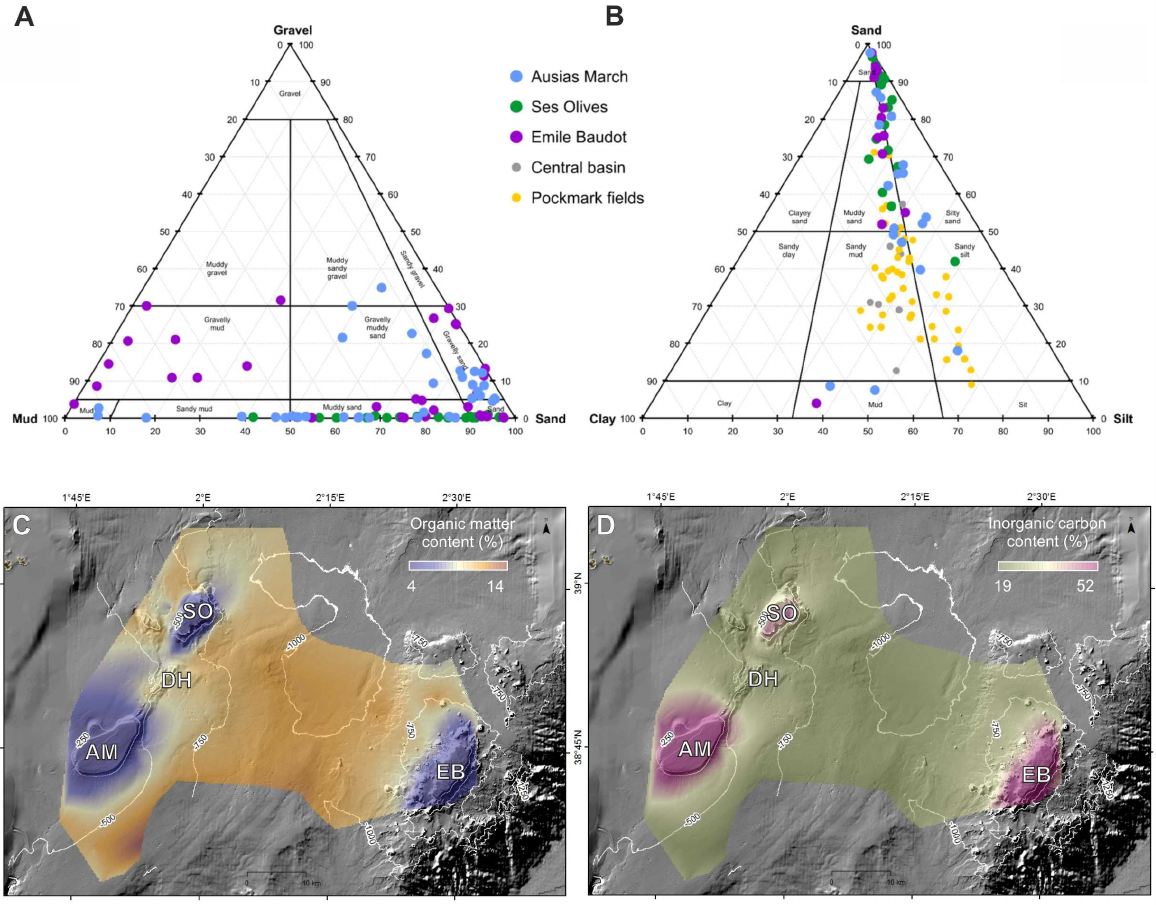
Figure 5. Surface sediment characteristics of the Ses Olives, Ausias March, and Emile Baudot seamounts, pockmark fields around them, and the central basin of the Mallorca Channel (Balearic Islands, western Mediterranean): ( A , B ) Folk (1954) classification diagrams indicating the particle size percentage variation of the surface sediment samples; ( C ) organic matter content percentage map; and ( D ) inorganic carbon content percentage map.